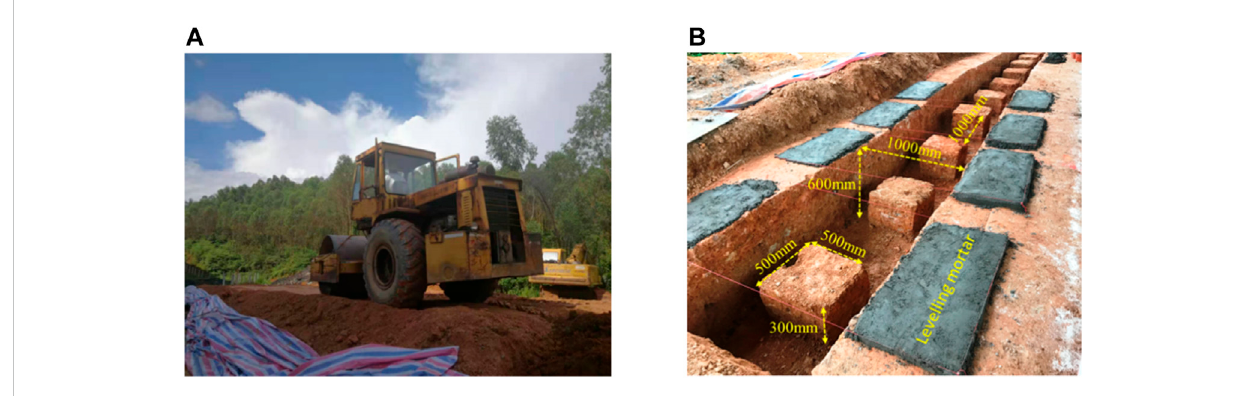
FIGURE 5 The test earth embankment and samples preparation. (A) Preparation of test soil-rock embankment, and (B) Preparation of large direct shear samples.